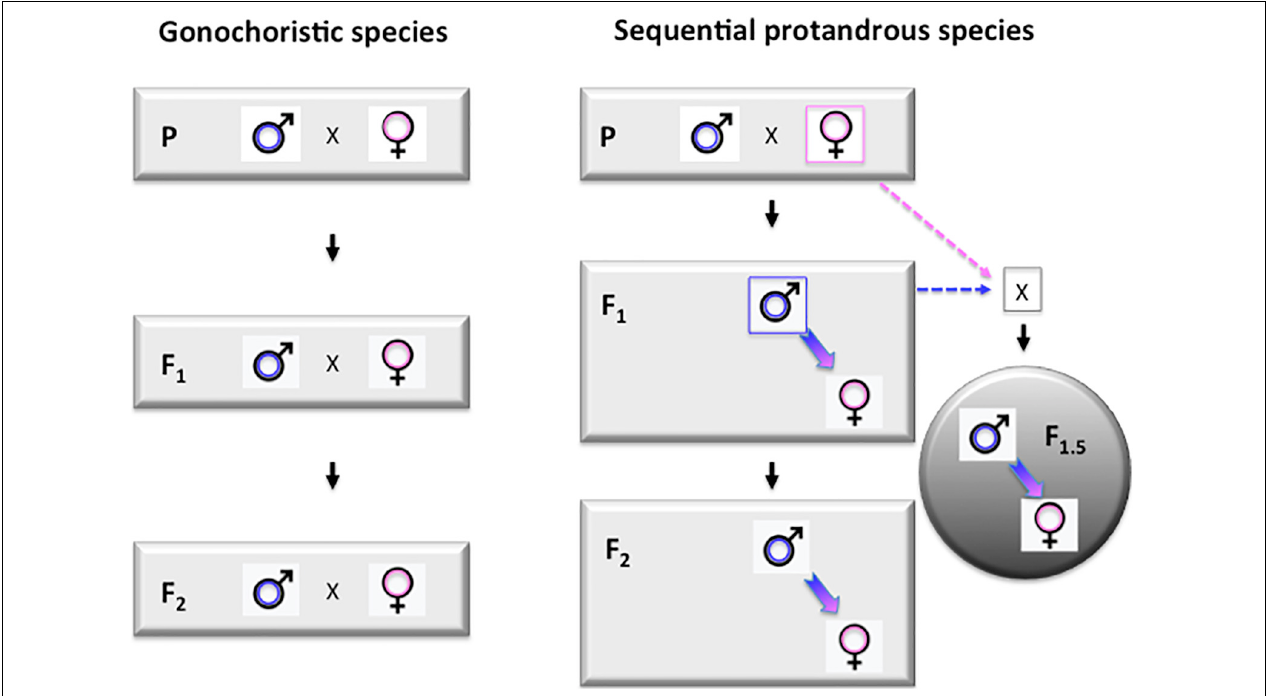
FIGURE 4 | Protandrous sequential hermaphroditism opens up the possibility for producing “intermediate generations” during breeding programs. Left panel: schematic representation of the first three (P, F1, and F2) generations in a typical breeding program performed on a gonochoristic species, when the two sexes mature during the same period. Right panel: breeding scheme for a protandrous sequential hermaphrodite, like Asian seabass. All individuals first mature as males, making the production of so-called “intermediate generations” (labeled with gray circle on the right side) possible by crossing these young males with females from the previous generation. For an F1 × P cross the resulting generation is called F1.5 as they are F2s from the paternal side and F1s from the maternal one. Labels: P – parental (F0) generation; F1 and F2 – the first two generations of selected individuals. F1.5 – an “intermedate generation” produced by back-crossing protandrous hermaphroditic F1 males to founder (P)